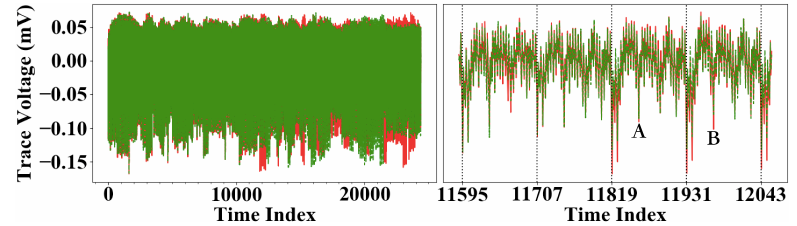
Figure 3: Target Trace Partitioning in the